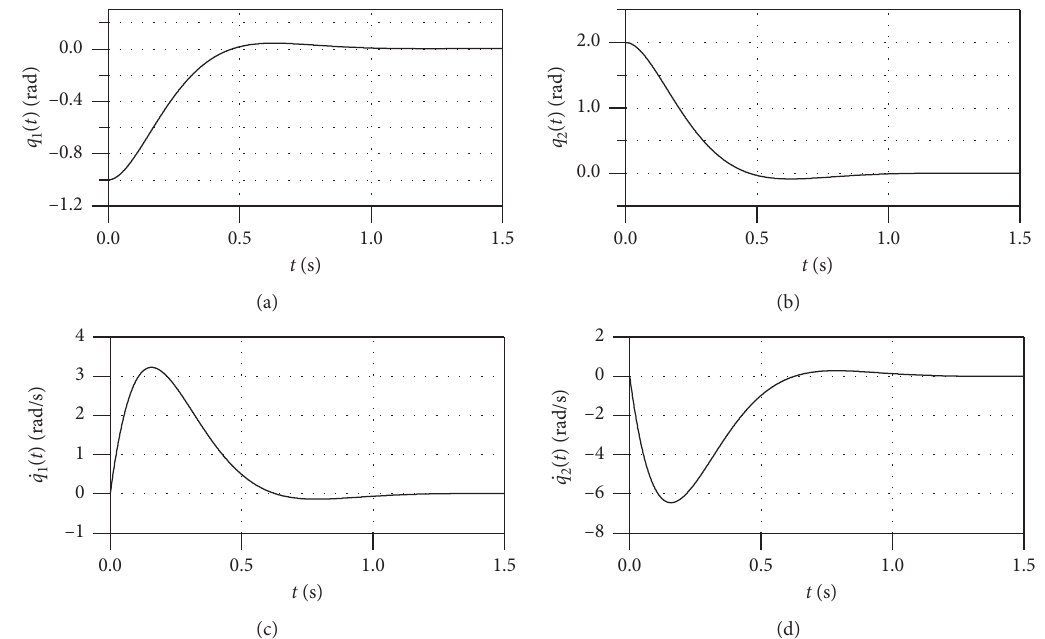
Figure 3: Time response of q